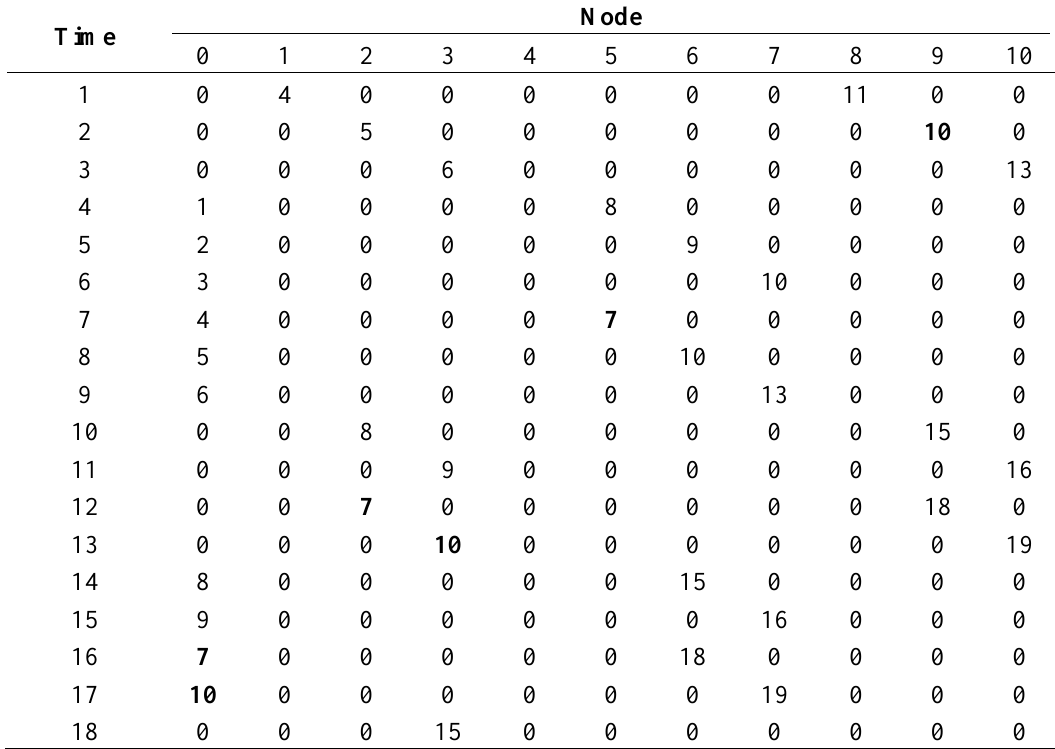
Table 5. Time schedule with ADJUST − (2) when n = 10, p =